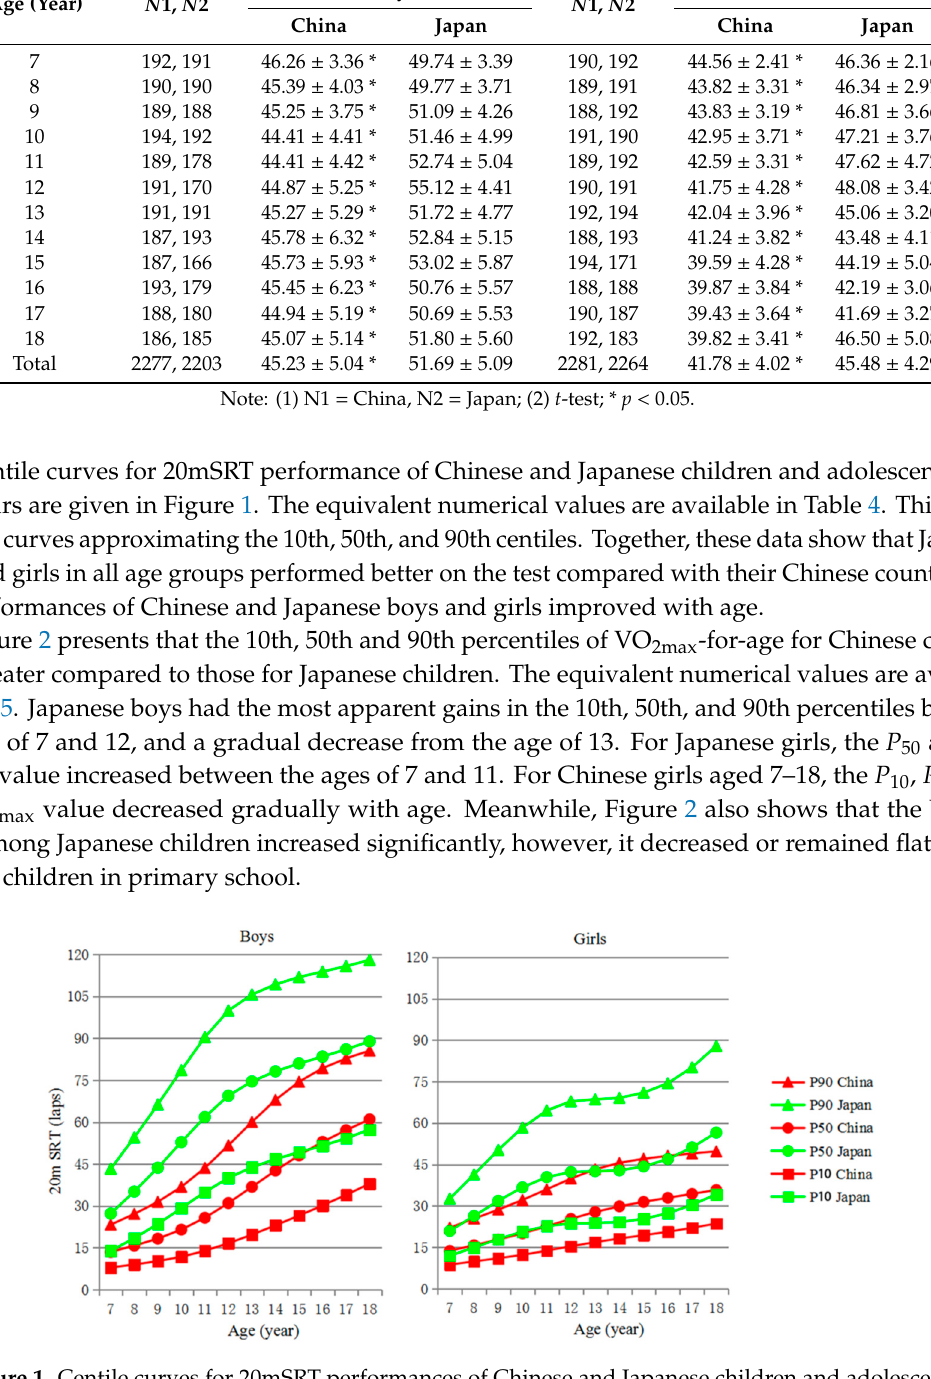
Figure 2. Centile curves for VO 2max values of Chinese and Japanese children and adolescents aged 7– 18 years. 4. Discussion The present study demonstrated that the CRF of Chinese children and adolescents was less than that of Japanese participants, which may be related to socioeconomic status, BMI, physical activity status, and dietary habits among children and adolescents. Since reform and opening-up in 1978, increased income inequality has emerged in China. Data from the Chinese Health and Nutrition Survey (CHNS) in the period 1989 to 2011 showed that an increased Gini index was associated with higher risks of having abnormal obesity [30]. Among 205,388 girls aged 13–14 years from 36 countries, those from higher income inequality countries had a greater median BMI [31]. BMI was closely correlated to CRF among children and adolescents. The relationship between BMI and CRF among children was parabolic, and the poorest CRF occurred with the highest BMI, while the best CRF occurred with normal weight [32,33]. In addition, overweight and obesity were significantly negatively correlated with CRF in children and adolescents [34], and obesity led to a decrease in children’s CRF [35]. Meanwhile, the results of the present study showed that the prevalence of overweight and obesity among Chinese participants in most age groups was greater, and the prevalence of normal weight was lower than that of Japanese participants. Therefore, the difference in BMI among Chinese and Japanese participants may be related to a significantly lower CRF among children in China than in Japan. Regarding the physical activity status, a survey of the mode of commuting to school among children from grade 4 to grade 12 in China found that among primary school, middle school, and high school students, the proportion taking an active mode of commuting (cycling or walking) to school was 55.8%, 54.6%, and 50.9%, respectively [36]. The 2015